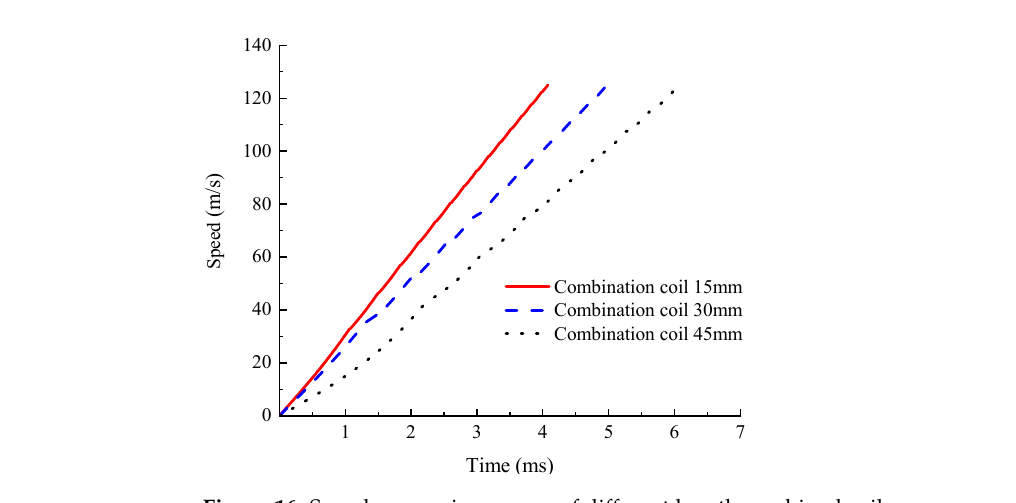
Figure 16. Speed comparison curve of different length combined coils